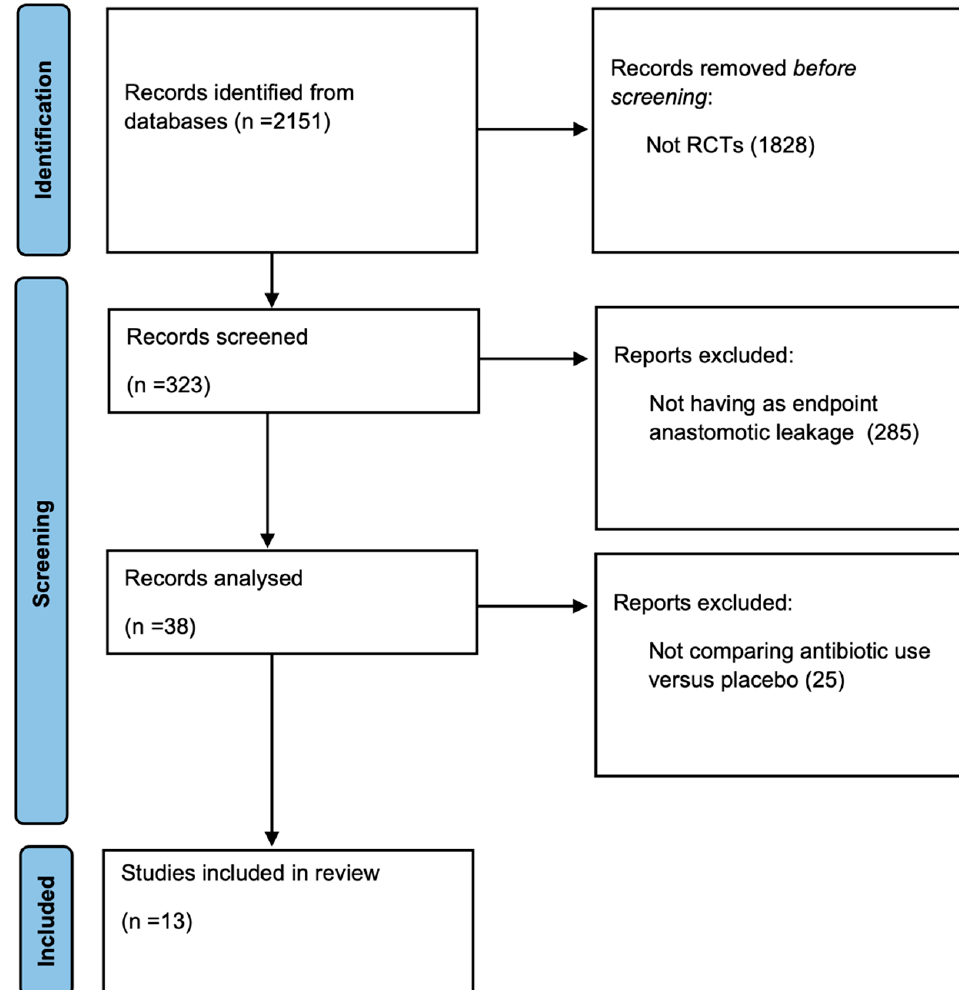
Figure 1. Flowchart of article selection. Table 1. Methodological quality assessment according to Jadad scores.